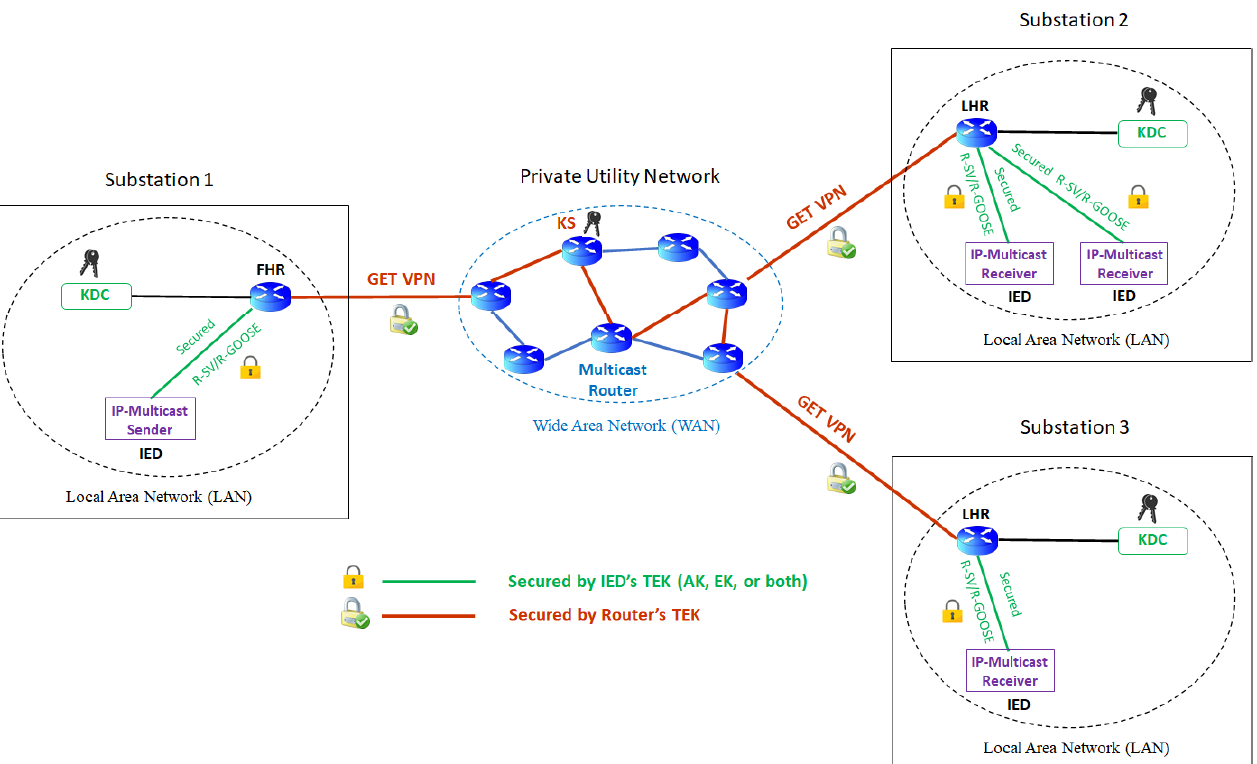
Figure 14. Secured messages in the secured communication path (Defense-in-Depth Security for multicast communication via private WAN).